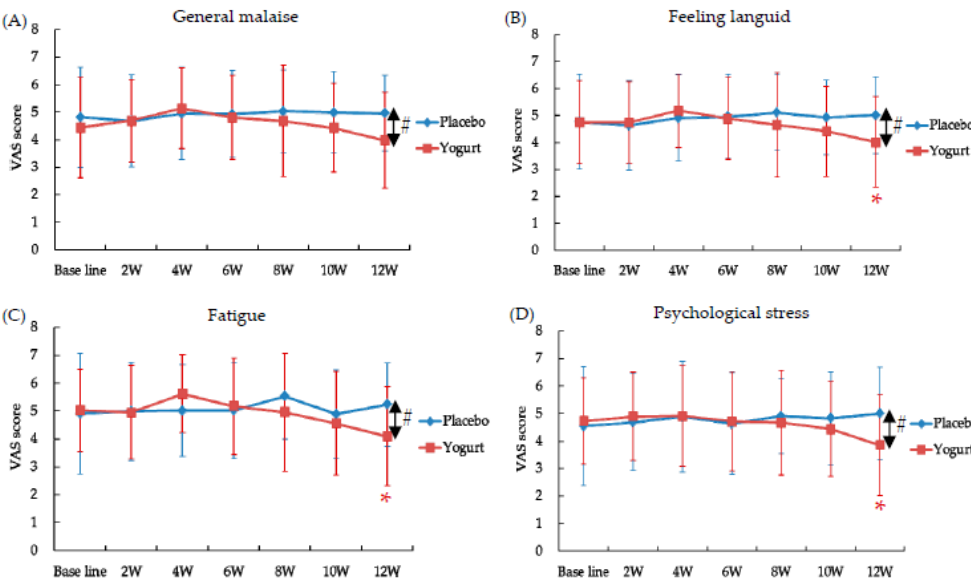
Figure 3. Effects of intake of yogurt fermented with L. bulgaricus OLL1073R-1 on the visual analogue scale (VAS) scores for general malaise ( A ), feeling languid ( B ), fatigue ( C ), and psychological stress ( D ). Data are presented as the mean ± standard deviation. * p < 0.05 compared to the baseline by paired t ‐ test. # p < 0.05 between the groups by t ‐ test.